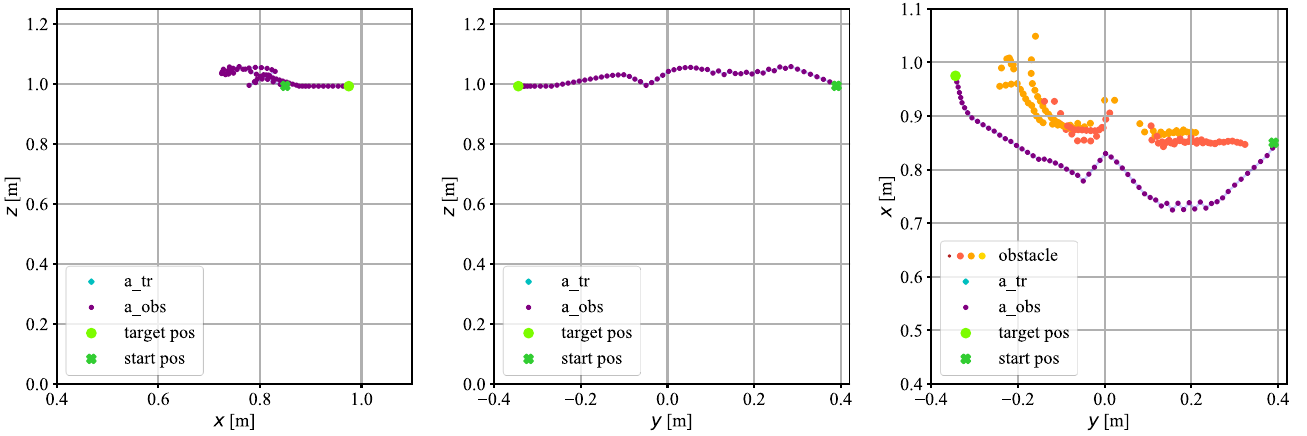
Figure 15. The trajectory on which the TCP of the robot moved in experimental research. Two obstacles: cuboid-shaped and cylinder-shaped.